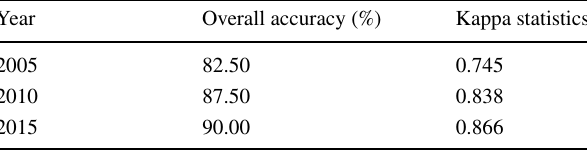
Table 5 Kappa statistics and overall accuracy of different years